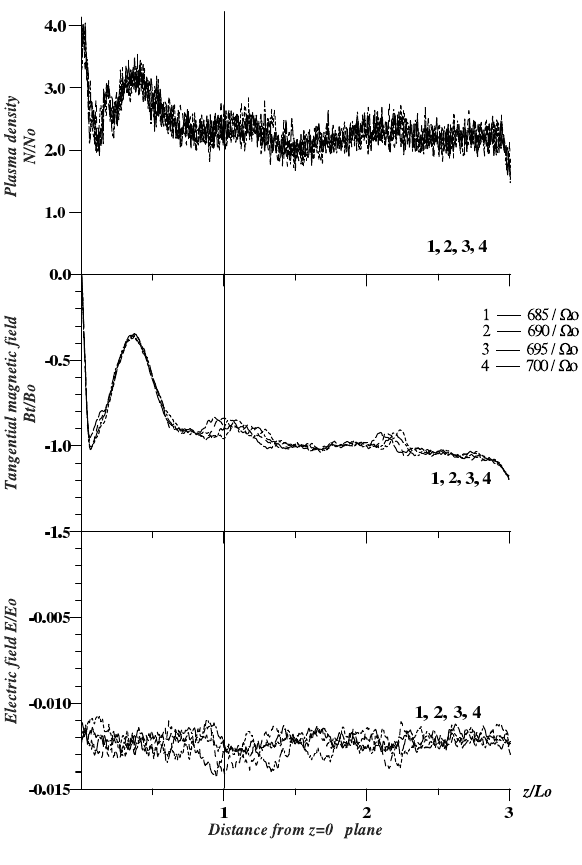
Fig. 2. The same profiles for t> 600/ (cid:127) 0 .